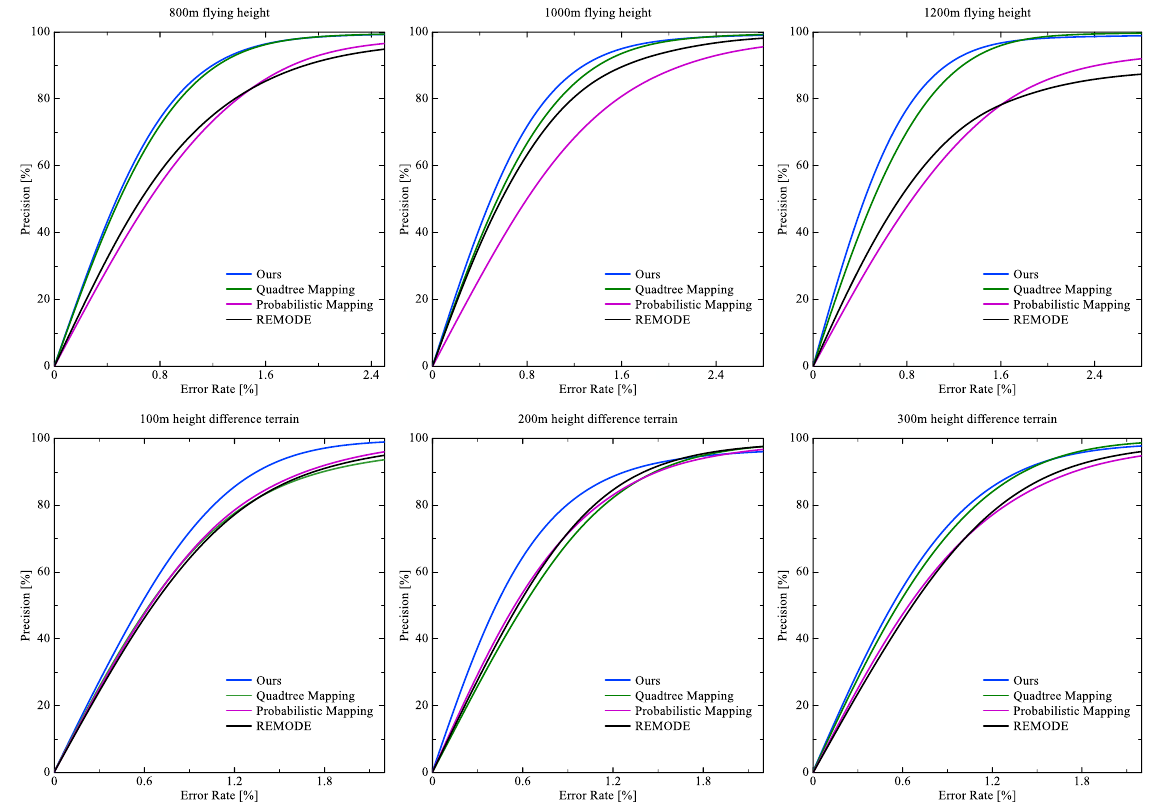
Figure 11. Comparison of relative depth error rate (% w.r.t m) in synthesized image sequences, which are divided into 800 m, 1000 m, and 1200 m three mean ground height and 100 m, 200 m, and 300 m three height difference terrain. We calculate the pixel percentage of converged measurements (vertical axis) within a certain relative error rate threshold (horizontal axis). The better performance has a higher percentage in any error rate threshold. Table 1. Detailed numerical values statistics of results of different methods on the synthesized datasets. The best metric value is highlighted in